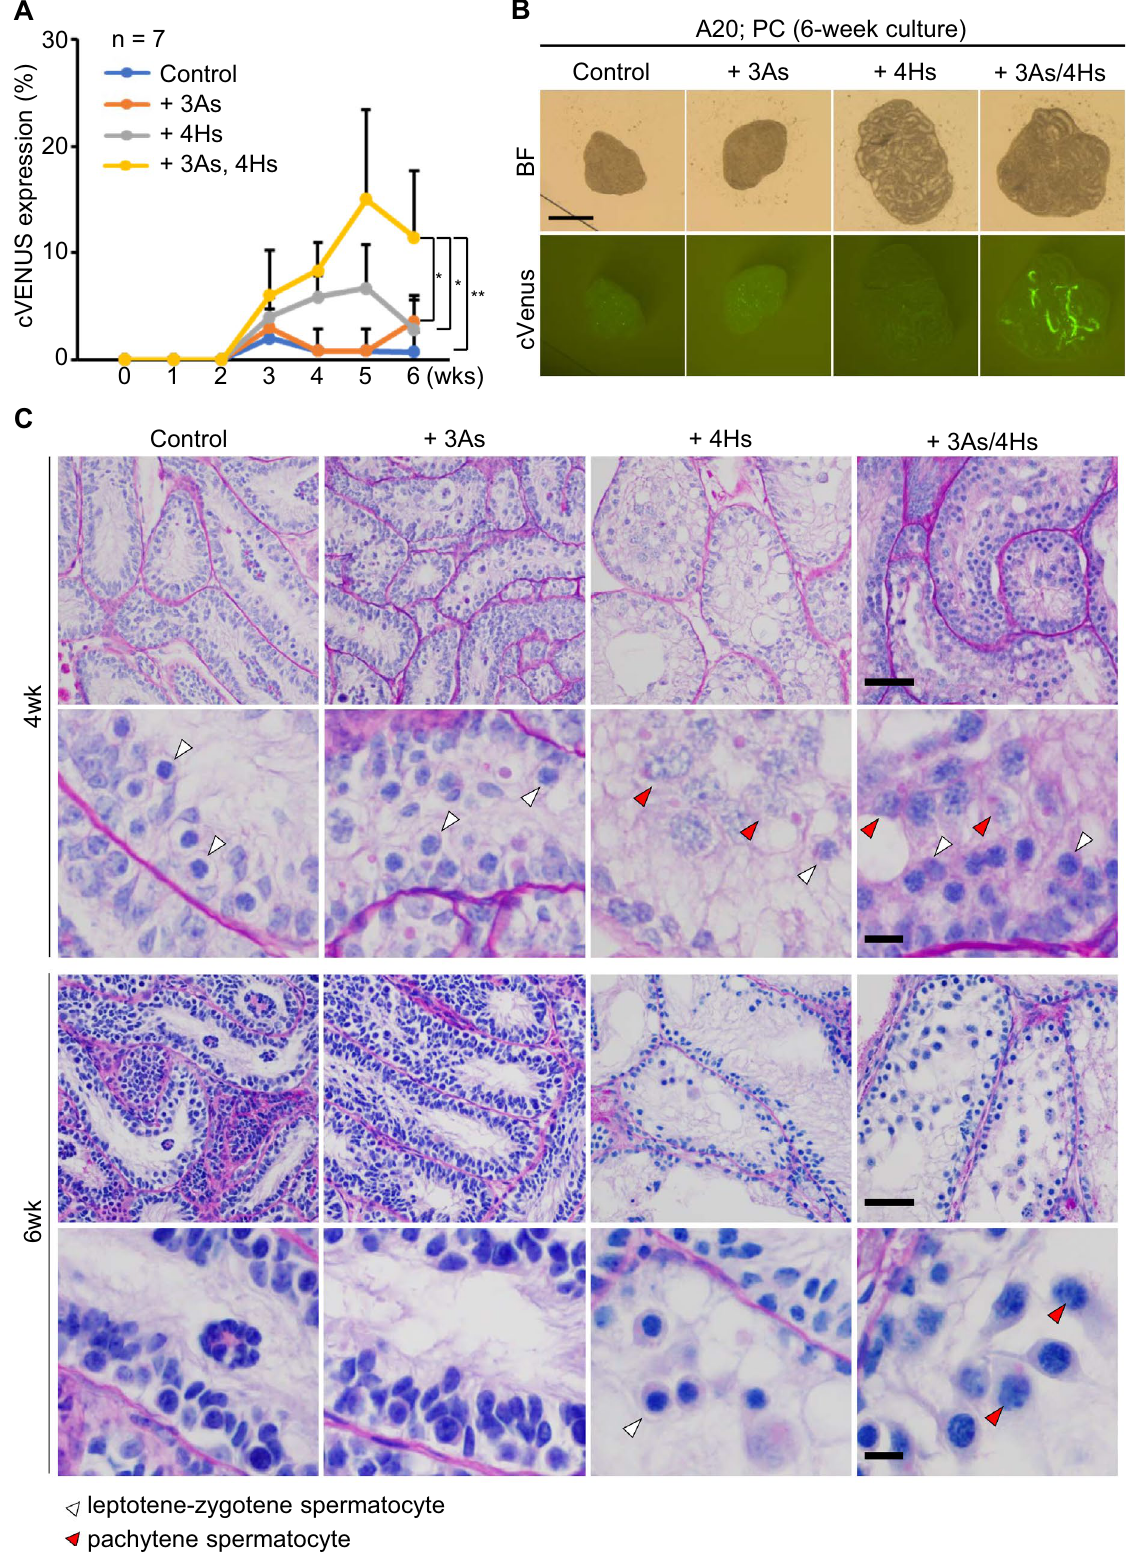
Figure 3. Antioxidants and hormones cooperatively promoted in vitro rat spermatogenesis. ( A ) The time course of cVenus expression area ratio of 4 groups was shown in a line graph. The culture medium of control group was αMEM + AlbuMAX (20 mg/mL). n = 7 (P4 and P7). Statistical significance; ** P < 0.01. * P < 0.05. ( B ) Photos of cultured tissues at week 6. Scale bar; 1 mm. ( C ) PAS staining histological pictures of cultured tissues at 4 and 6 weeks. White and red arrowheads indicate leptotene/zygotene and pachytene spermatocytes, respectively. Magnified images are shown in 2nd and bottom row. Scale bar; 50 µm (top and 3rd row). Scale bar; 10 µm (2nd and bottom